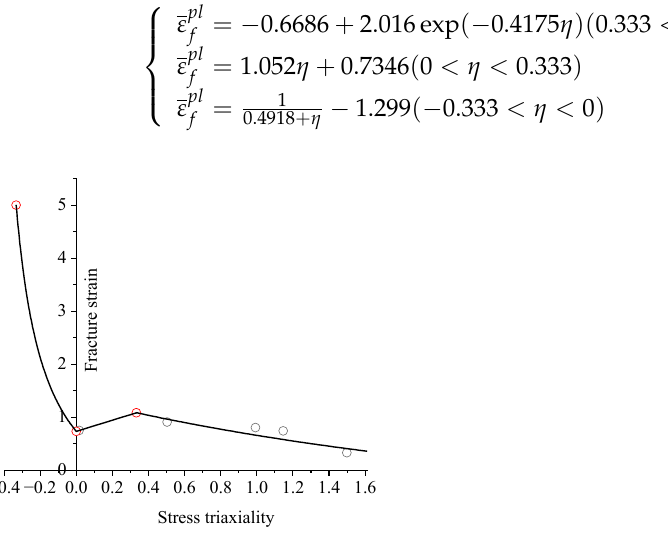
Figure 12. 2D fracture model.